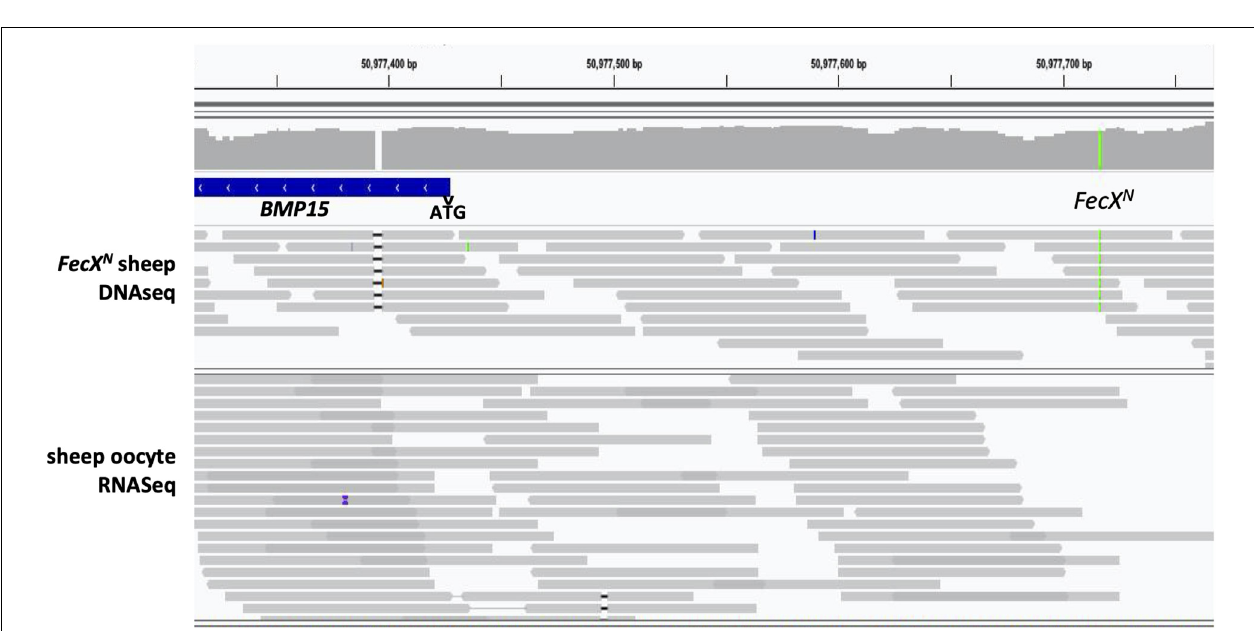
FIGURE 4 | Estimated effect of FecX N . (A) Estimated effect of FecX N knowing FecL L genotype in Noire du Velay (NV). (B) Estimated effect of FecX N according to induced or natural estrus in Blanche du Massif Central (BMC). Estimated increased LS and the corresponding standard errors from the linear mixed models with interaction between genotypes at the FecX and FecL loci for NV, and between FecX genotype and estrus type for BMC are given relative to L and N alleles non-carrier ewes (+/+). Different letters indicate significant differences ( P < 0.01).